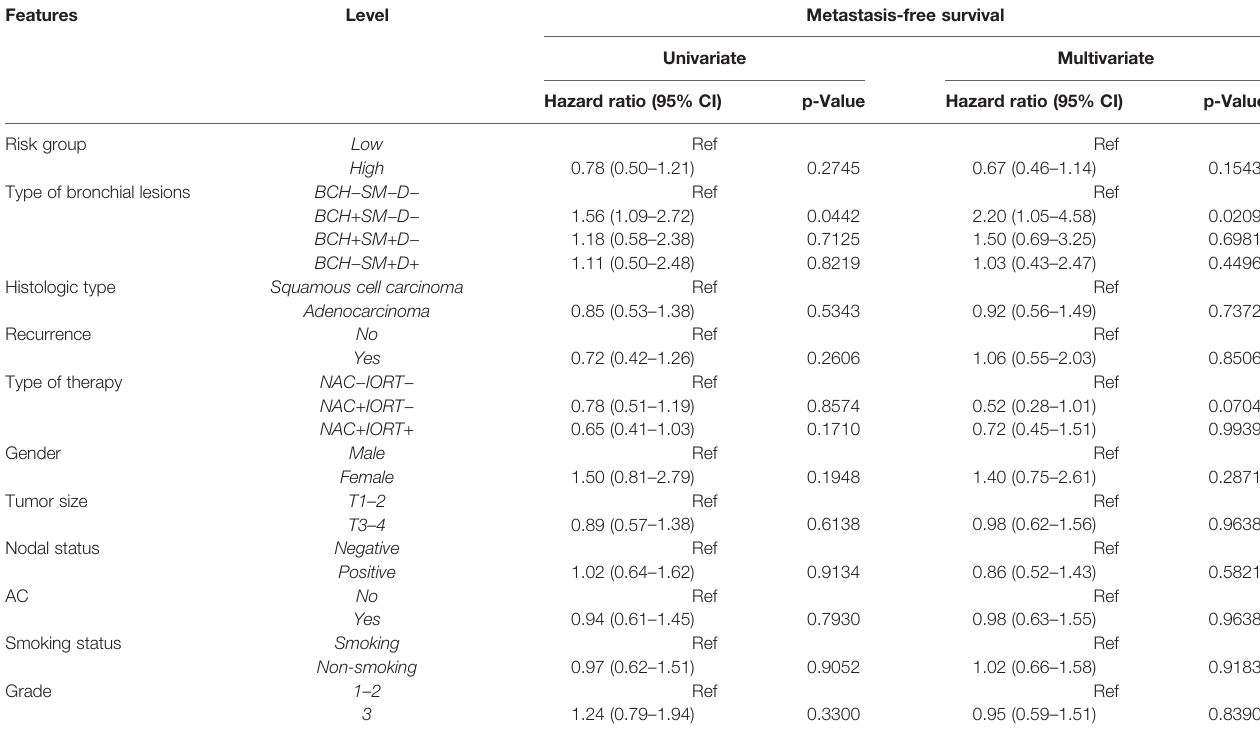
TABLE 6 | Univariate and multivariate Cox regression analyses of prognostic factors for 5-year metastasis-free survival in NSCLC patients. Features